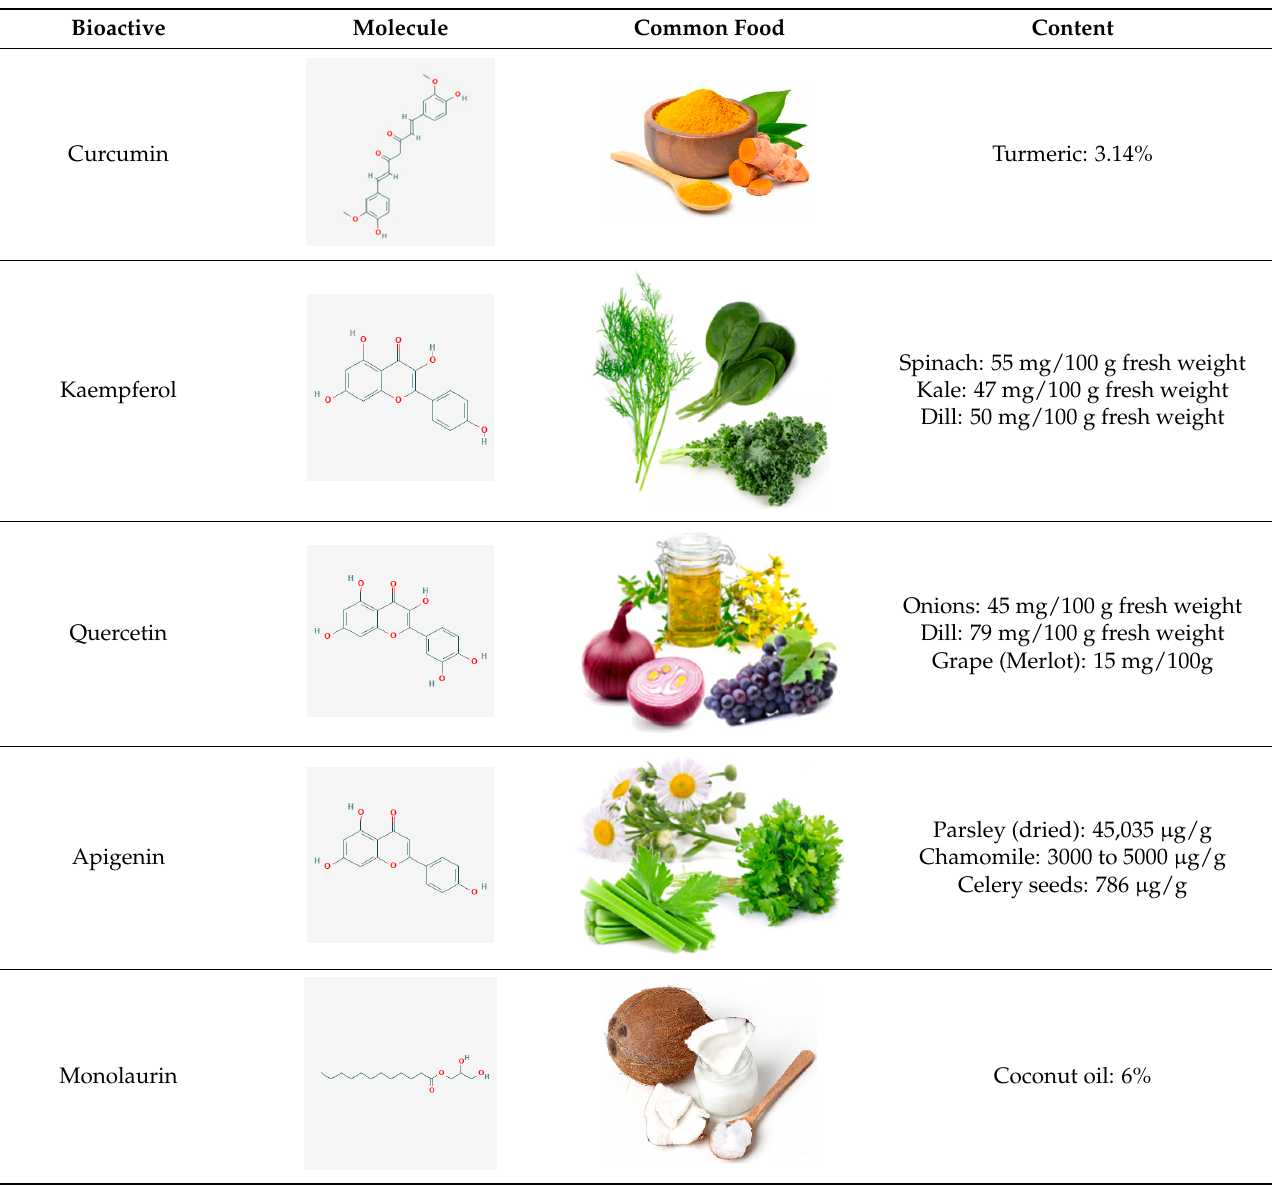
Table 2. Summary of the bioactive compounds selected and common foods and content.